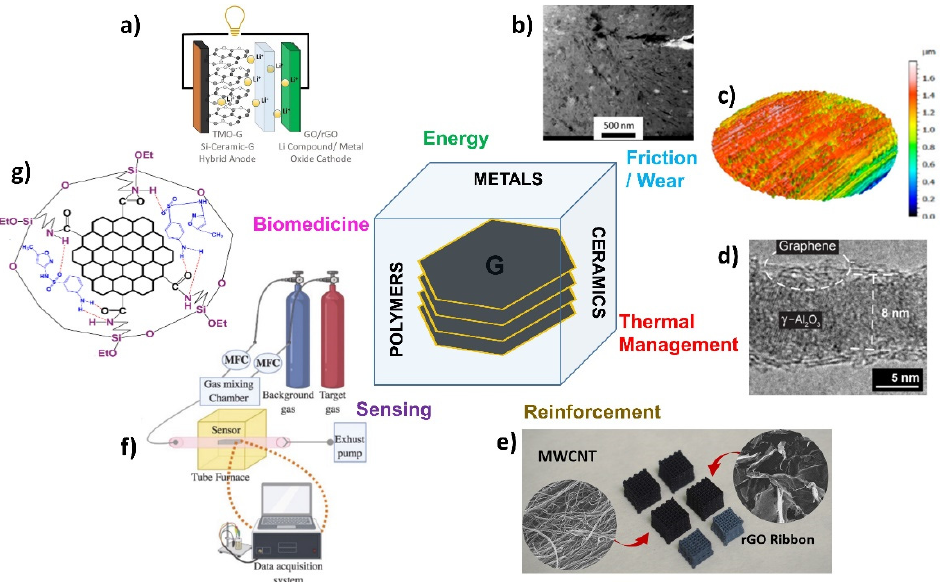
Figure 1. A schematic diagram of the graphene composites spectrum and their potential uses along with representative examples of materials and uses from the articles included in this Special Issue. ( a ) A schematic of the applications of graphene-based composites in Li-ion battery electrodes described in [11]; ( b ) a high annular dark field (HAADF) micrograph of an Al/2GNP/1Al 2 O 3 composite [13]; ( c ) an isometric view of a PAO8/ZDDP/graphene W-DLC surface after a ball-on-disc test [14]; ( d ) CVD graphene-coated γ -Al 2 O 3 nanofiber [15]; ( e ) reinforced 3D-printed MWCNT and rGO/Al 2 O 3 scaffolds [16]; ( f ) a schematic of an experimental setup for gas-sensing applications [10]; ( g ) a schematic diagram of sulfamethoxazole detection by silica-coated GQDs [12]. Funding: This research was funded by the Spanish Ministry of Science and Innovations (MICINN/AEI) and FEDER (UE), grant number RTI2018-095052-BI00. CR acknowledge the funding from Juan de la Cierva Incorporación Postdoctoral Program (IJCI-2017-34724). Conflicts of Interest: The authors declare no conflicts of interest.